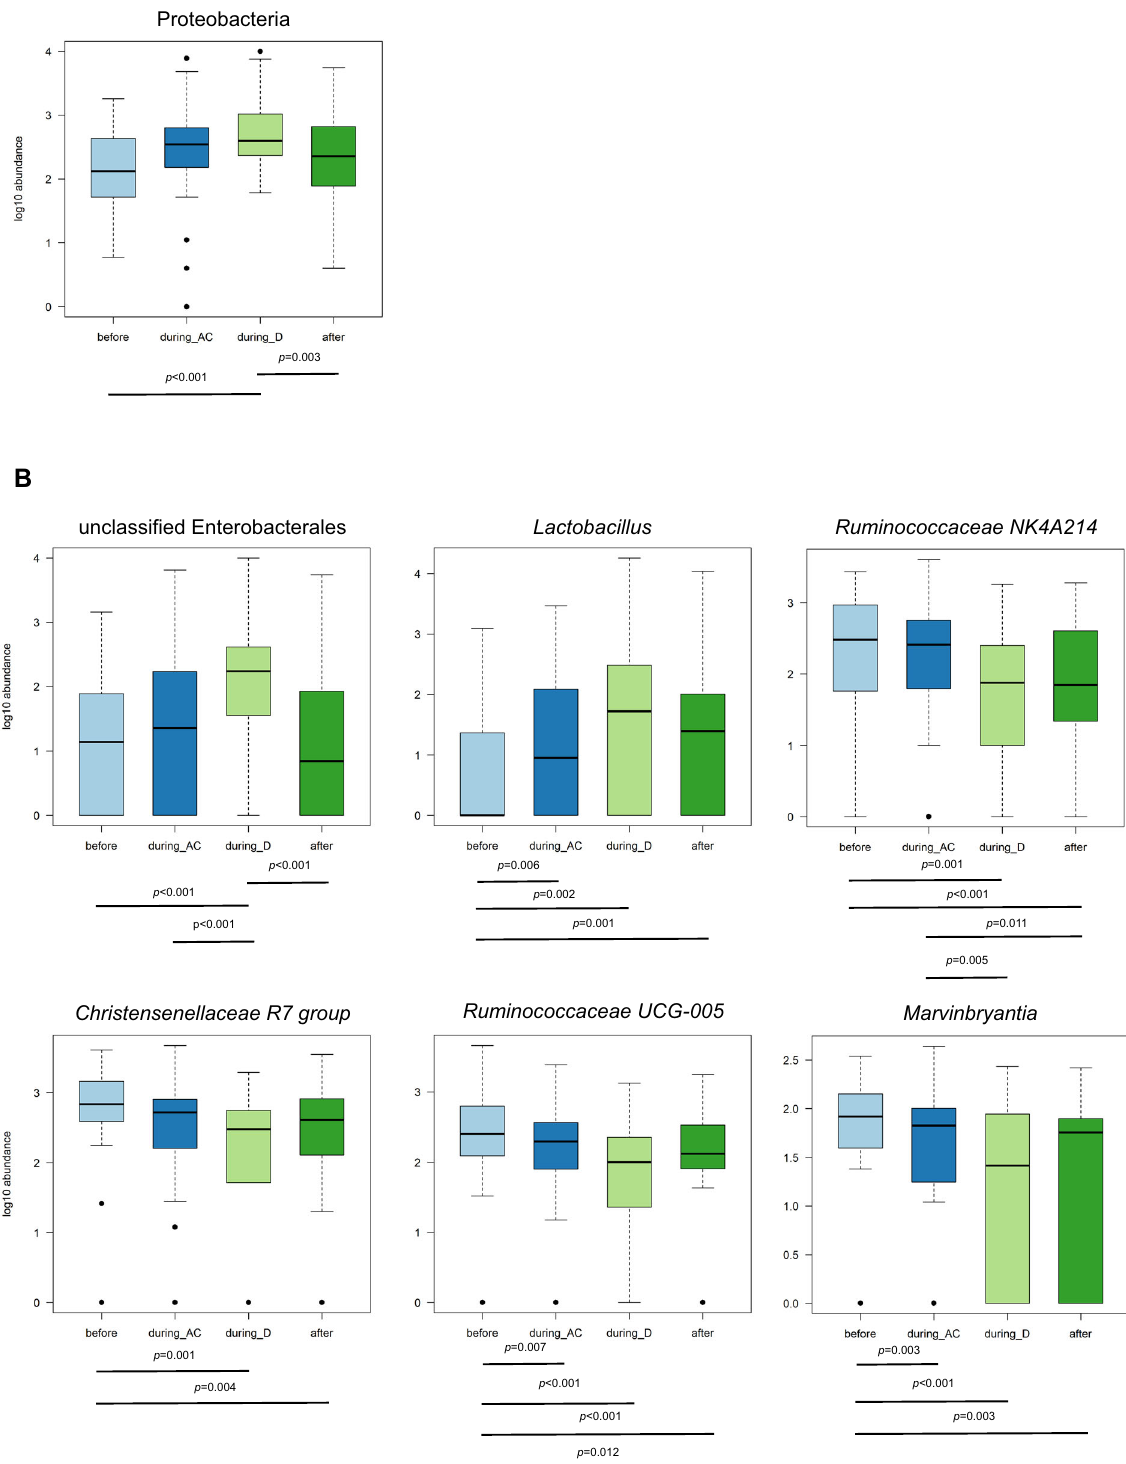
Fig. 5 Differential abundant taxa during the course of AC-D. Log 10 abundance of taxa with signi fi cant differential abundance before AC-D ( n = 44), during AC ( n = 43), during D ( n = 29) and after AC-D treatment ( n = 37). P values below boxplots indicate signi fi cant differential abundances analysed with a pairwise Wilcoxon signed-rank sum test (Supplementary Table 10). A Phylum level. B Genus level. The boxplots show the medians, IQRs, minimum, maximum and